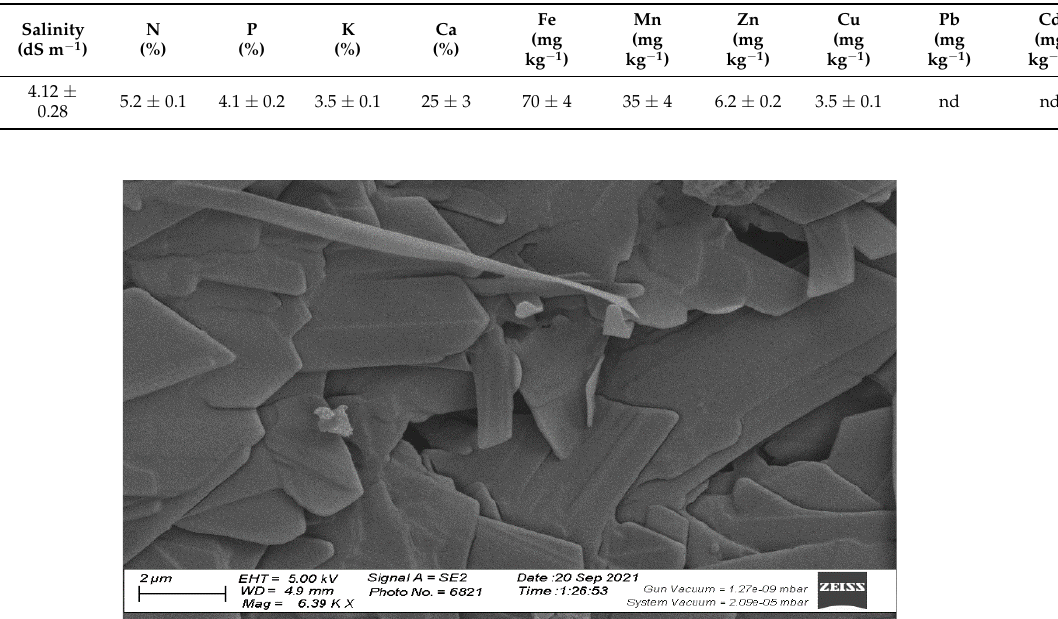
Figure 1. The SEM image of shrimp waste biochar. Table 1. Characterization of shrimp ‐ waste ‐ derived biochar (SWB). nd = not detected. Organic ‐ C